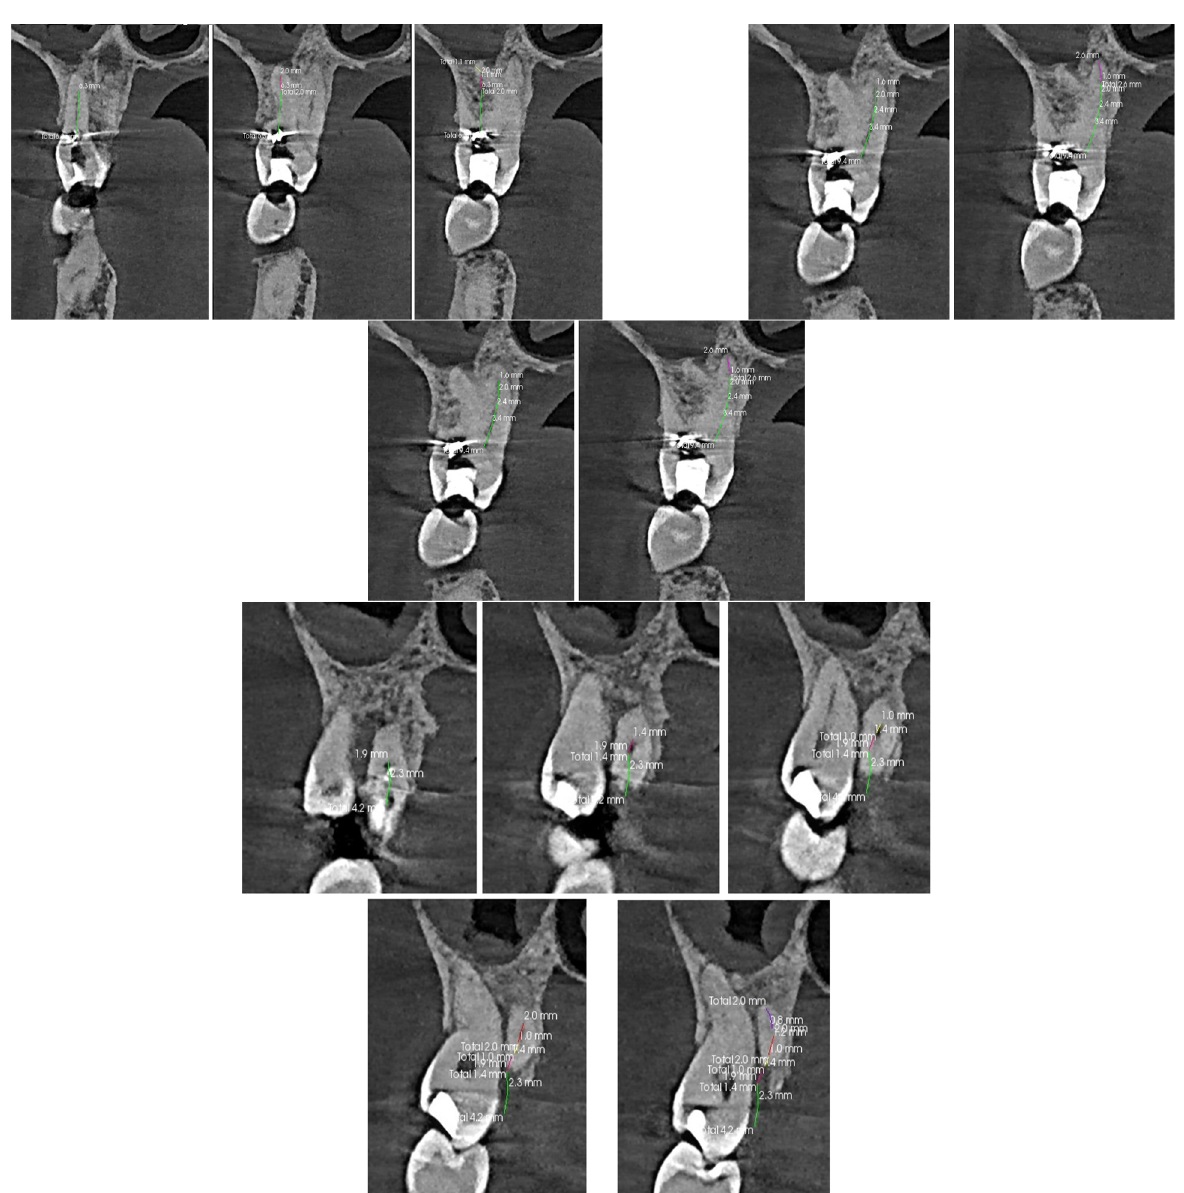
Figure 7. The CT scan of the tooth was used for the analysis of the root canals in the transverse plane, in the case of tooth 17 with carious pulp exposure.